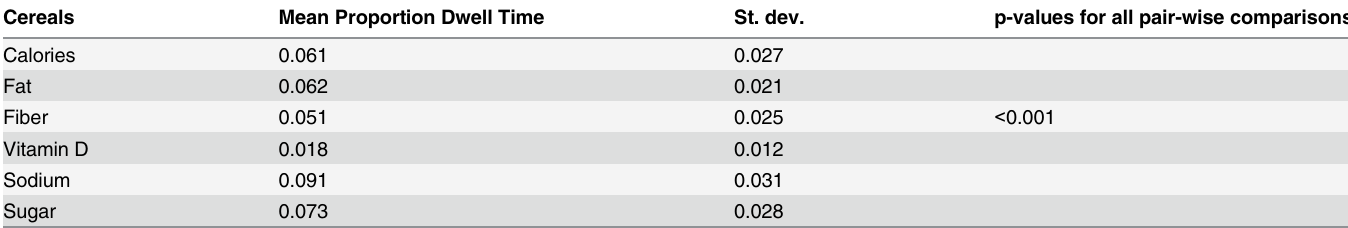
Table 2. Average proportion dwell times by Front-of-Package nutrition types for Cereals. P-values are Tukey-Kramer adjusted for multiple comparisons. Cereals